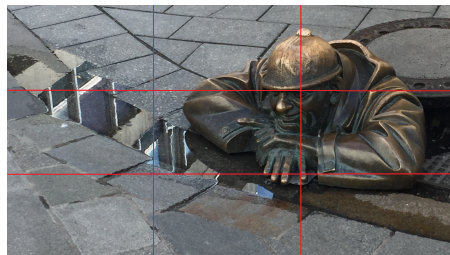
Figure 6. An example image using the rule of